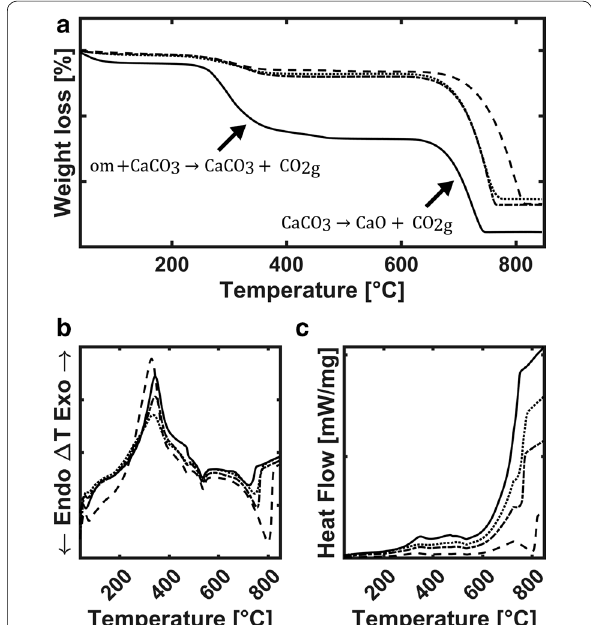
Fig. 6 Phase transition of composites formed on different media. a Thermogravimetric (TGA) profile and material weight loss of organic matrix (om), carbon dioxide (CO 2 ) and calcium oxide (CaO). b Differential thermal analysis and c differentia scanning calorimetry (DSC) show degradation enthalpy and crystalline transition of amorphous calcium carbonate (ACC) to crystalline CaCO 3 . Lines indicate BCC‑GLY (solid), BCC‑GLC (dot), BCC‑LAC (grid), and BCC‑ACE